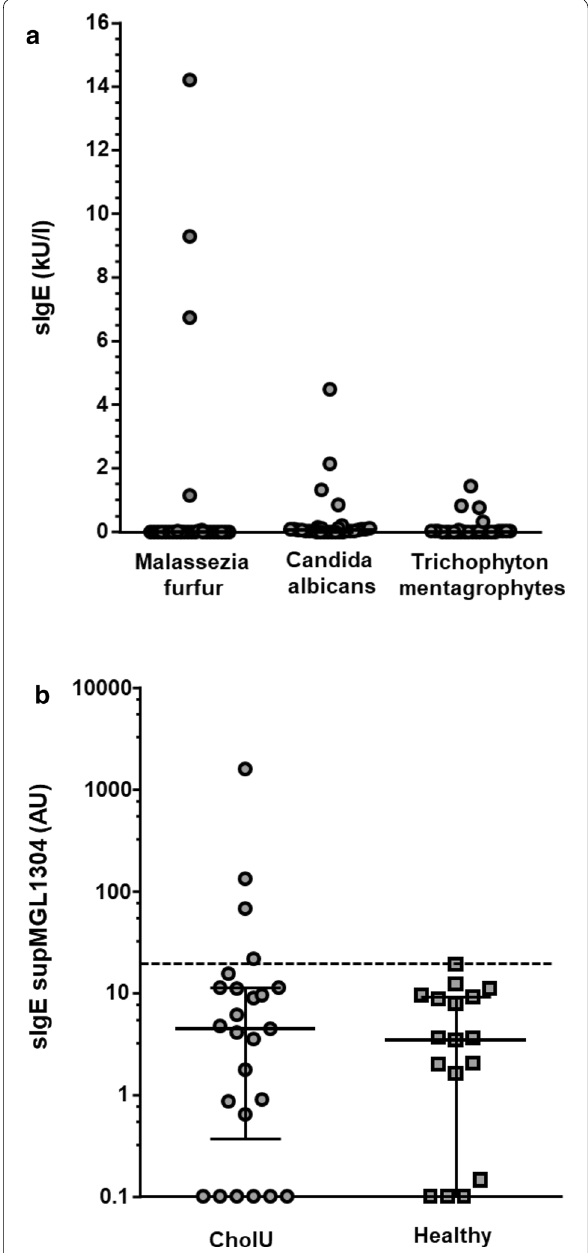
Fig. 1 Specific IgE levels against skin fungi in CholU patients (n ( a ), and against supMGL-1304 in CholU patients (n controls (n 20) ( b ). Individual patients are displayed as dots. b = Shows median and interquartile ranges of specific IgE levels against supMGL-1304. 95% percentile calculated from healthy controls is represented by a dashed